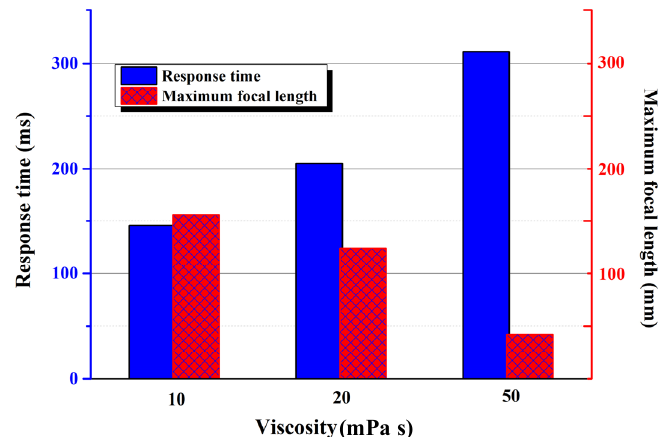
Figure 7. Response time and the maximum focal length under different liquid